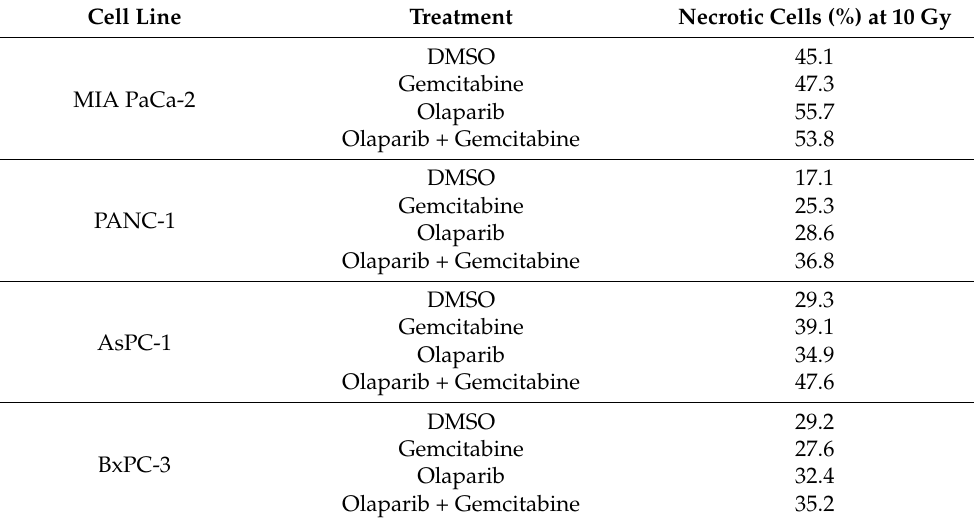
Table 4. Mean values of necrotic cellsfrom PDAC cell lines at 48 h after 10 Gy